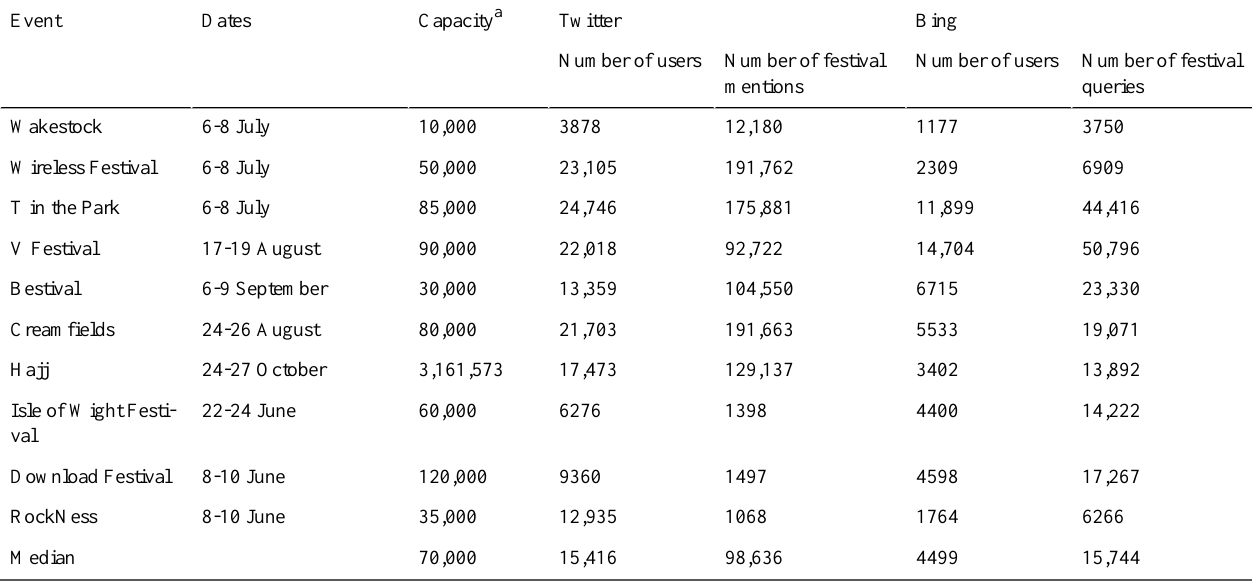
Table 1. List of analyzed events and statistics.